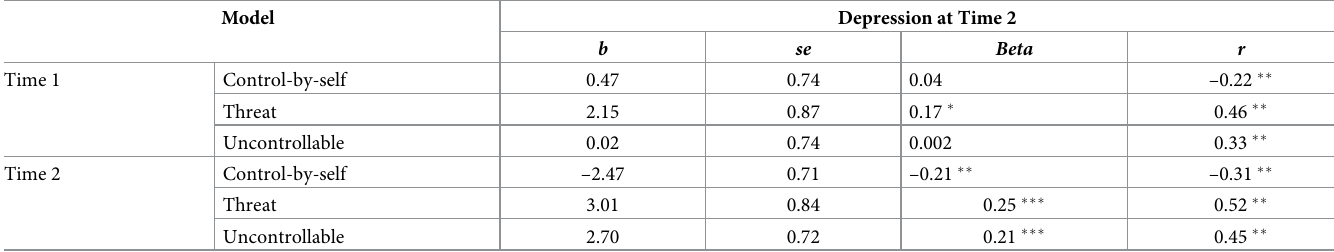
Table 4. Regression coefficients for appraisals at Times 1 and 2 predicting depression at Time 2 based on final step